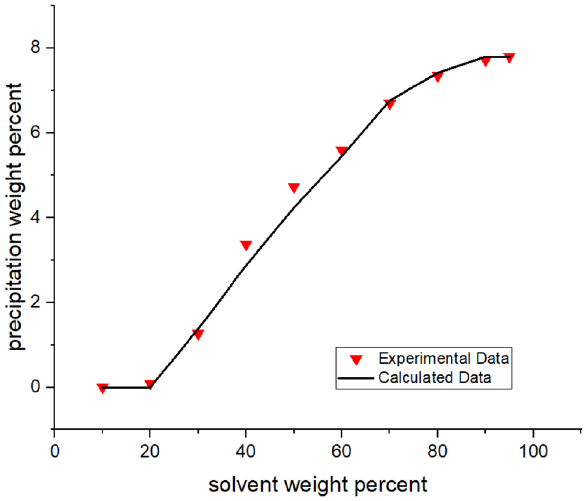
Figure 2. Asphaltene precipitation from the oil sample B versus solvent percent: obtained from experimental and modeling approaches.